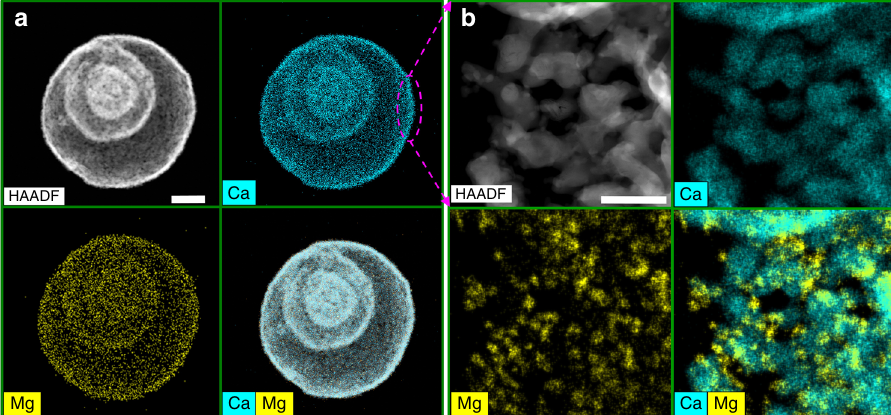
Fig. 3 Compositional homogeneity. a , b Low-magni fi cation and high-magni fi cation HAADF-STEM images of Ca85Mg15 along with EDX elemental mapping showing the distribution of Ca and Mg in the sorbents following the thermal removal of the template, respectively. Scale bar: 1 μ m in a , and 200 nm in b ,